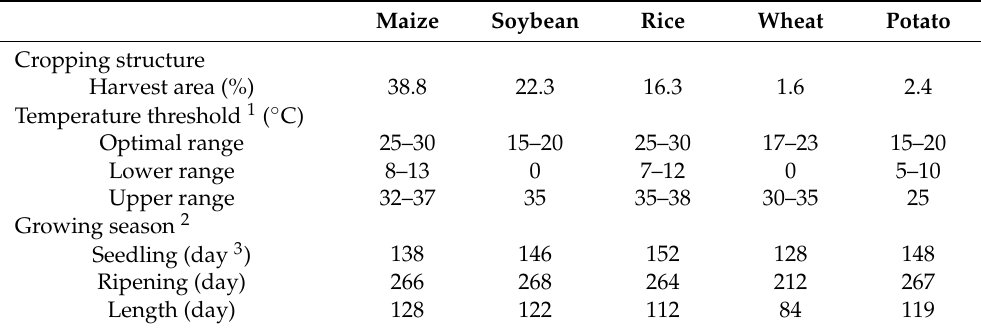
Table 1. Cropping structure, temperature threshold, and growing season of major crops in Northeast China from 2001 to 2010.